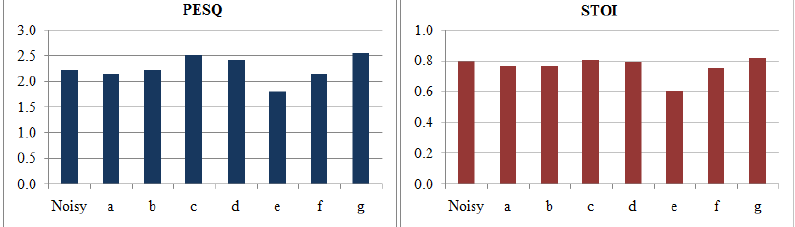
Figure 4. Average PESQ and STOI results for the seven DNNs at six SNR